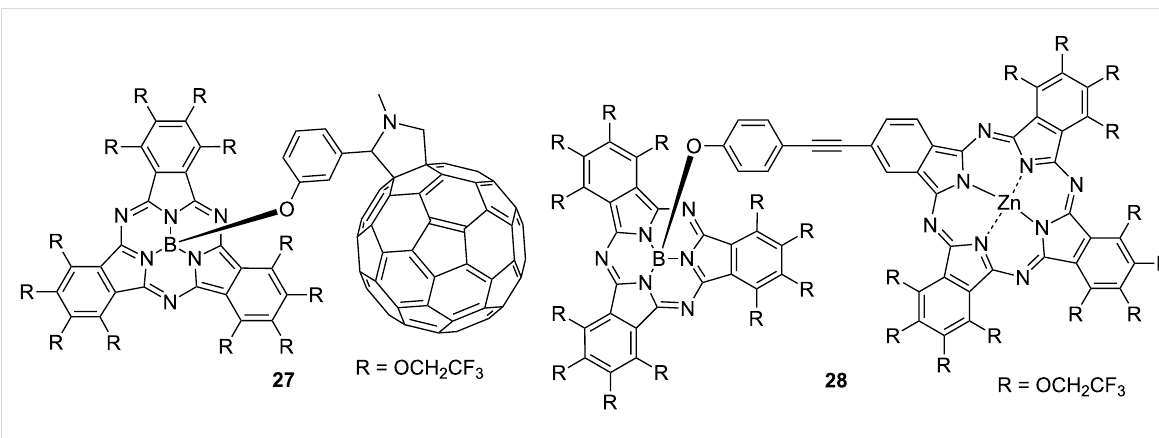
Figure 7: Structure of axial ligand substituted subphthalocyanine hybrid dyes.